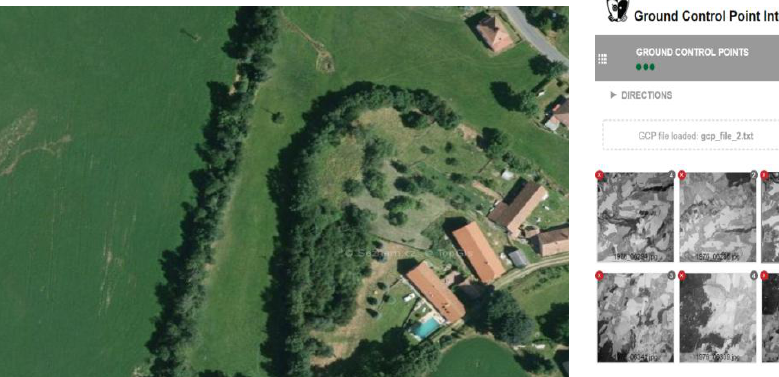
Figure 11 Web application to measure coordinate reference points 2.2.5